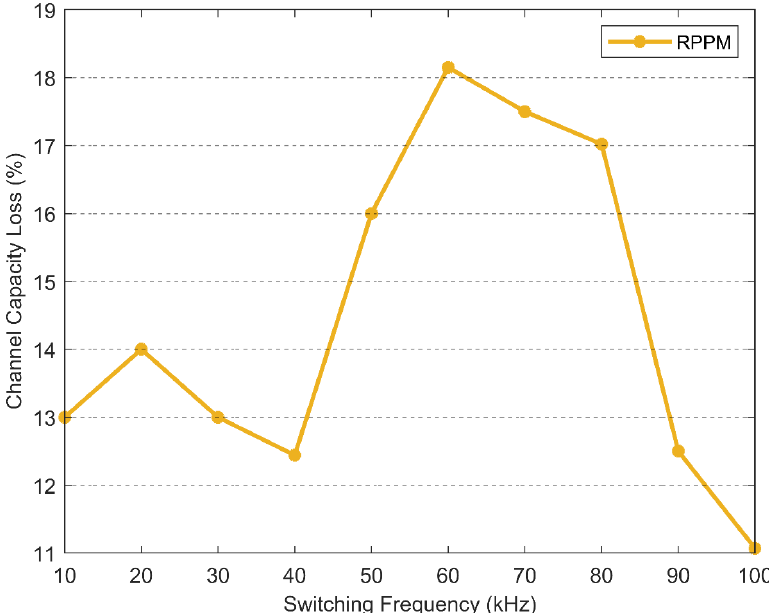
Figure 9. Channel Capacity Loss of the G3 ‐ PLC with different switching frequencies applied to the RPPM ‐ modulated DC ‐ DC converter.